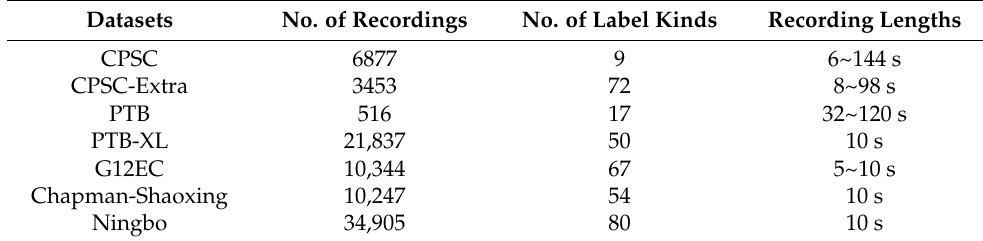
Table 1. Information of the datasets used in this study. Datasets No. of Recordings No. of Label